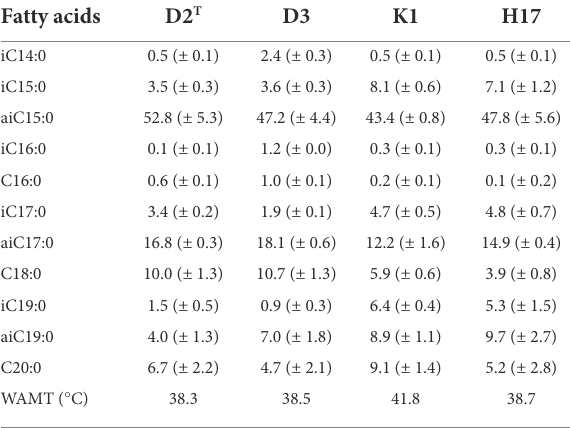
TABLE 3 Fatty acid patterns of Staphylococcus capitis subsp. capitis strains D2 T , D3, K1 and H17.